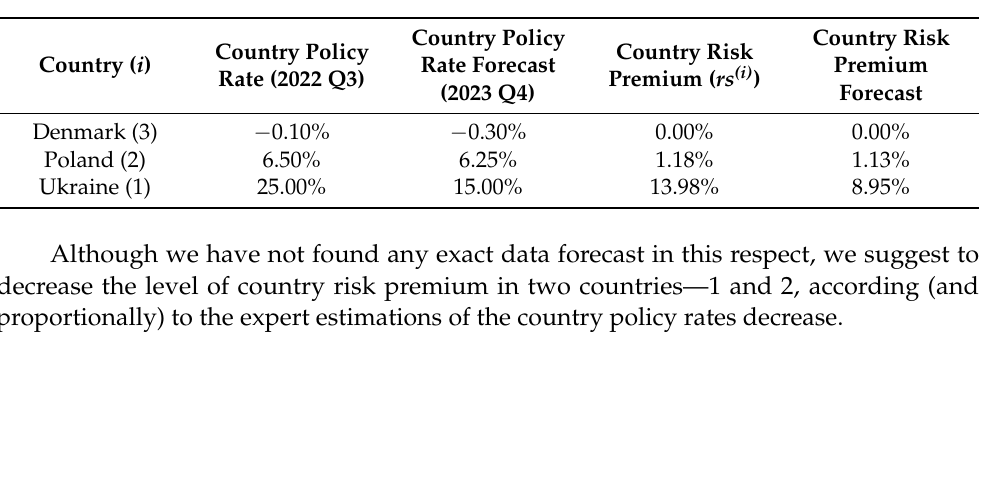
Table 2. The current and projected level of the interest rate in the three considered countries.